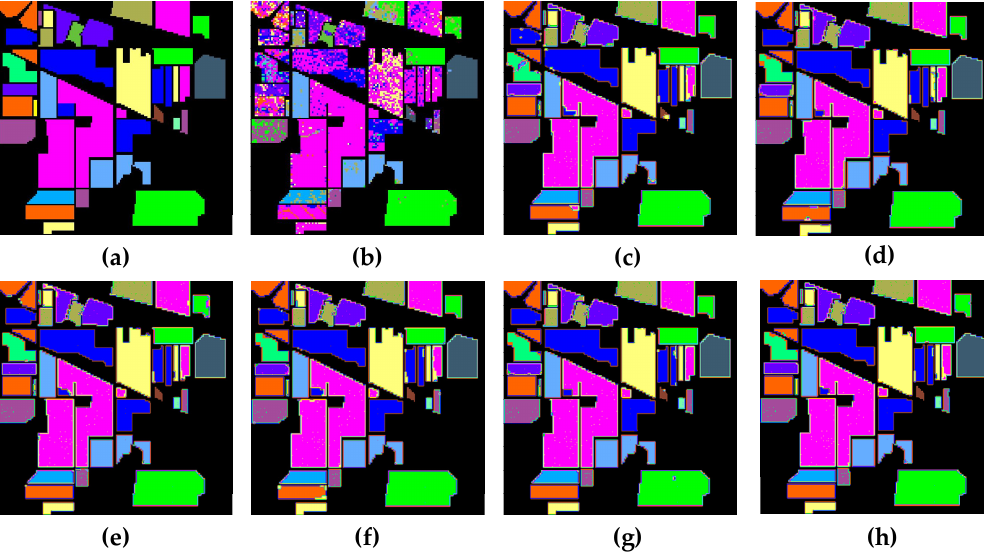
Figure 20. Classification maps acquired by each method for the Indian Pines dataset: ( a ) ground-truth image, ( b ) SVM, ( c ) 2DCNN, ( d ) 3DNN, ( e ) SSRN, ( f ) HybridSN, ( g ) SSAN, ( h ) proposed TSSFAN.